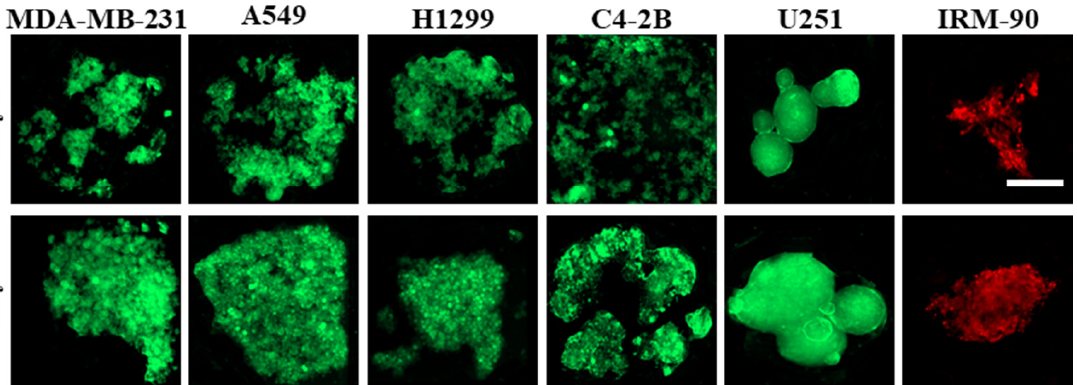
Figure 3. Culture of different cell lines on PDMS biochips pre-coated with 3% BSA. Cell adhesion pattern to the surface is different, and it depends on the cell type. In some cell lines, like C4-2B, cell–substrate interactions are dominant over cell–cell interactions; therefore, they cannot form compact cell clusters on surfaces treated with 3% BSA. On the other hand, some cell lines like U251 demonstrated greater cell–cell interactions when compared with cell–substrate interactions; therefore, this leads to the formation of more compact cell clusters. The red color is due to red-fluorescent protein (RFP) in IRM-90 cells and the green color is due to green-fluorescent protein (GFP) in MDA-MB-231 cells. For other cell lines, the green color is due to being fluorescently labeled with cell-labeling solution Vybrant Dio V22886. Scale bars: 200 µ